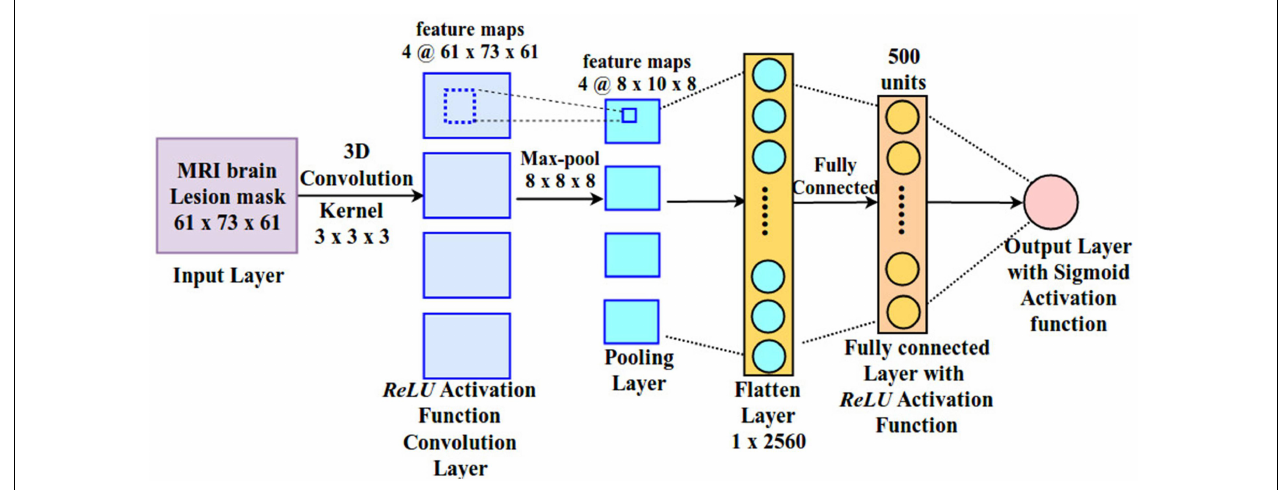
FIGURE 3 | Architecture of the deep convolutional neural network